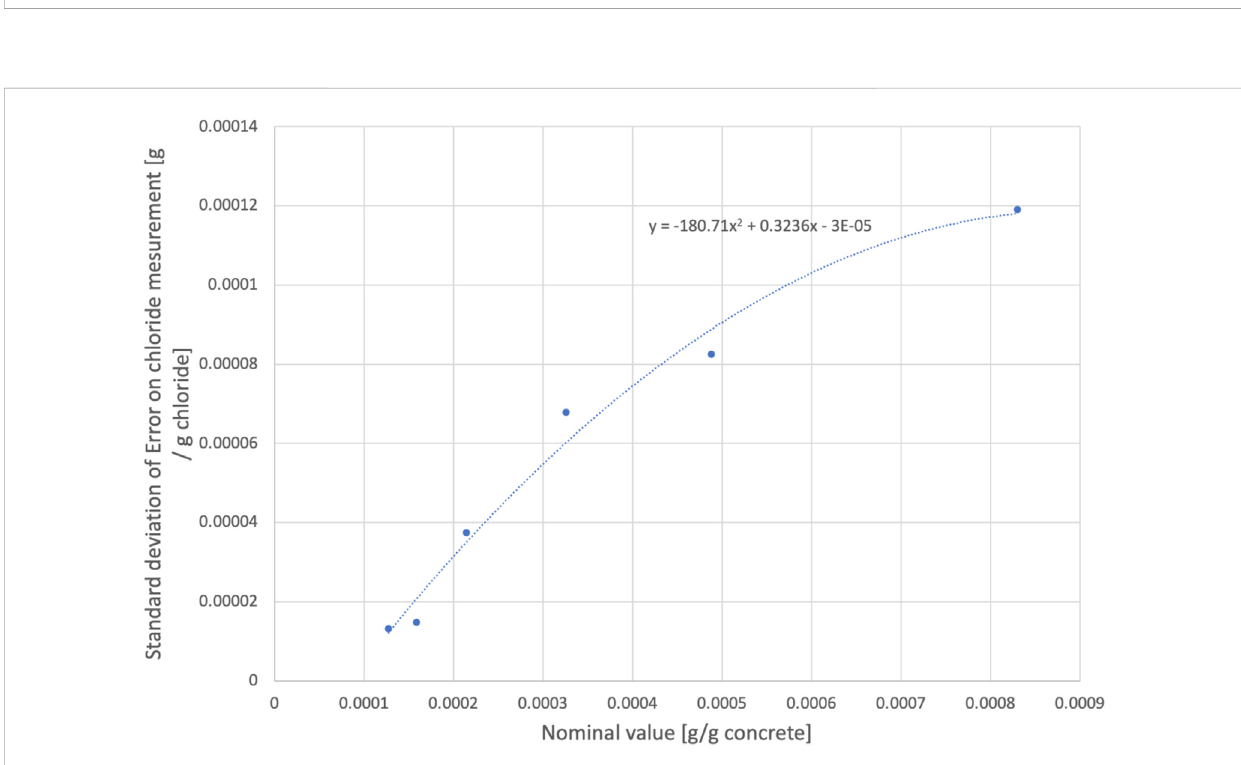
FIGURE 6 Evolution of the standard deviation of error of measurement as a function of reference.